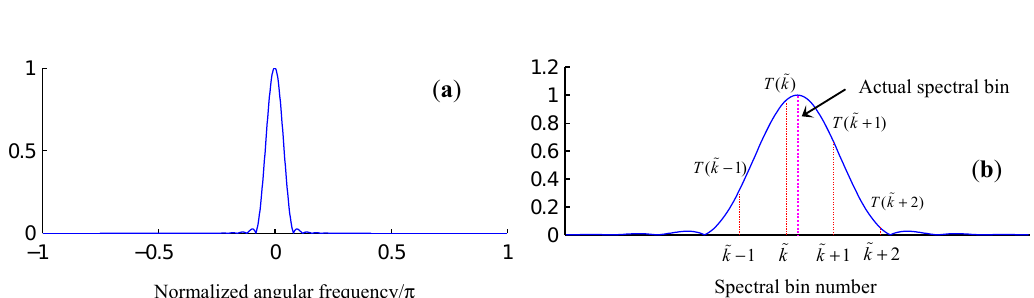
Figure 4. Hanning window-based spectrum correction: ( a ) the magnitude response; ( b ) the spectral bins within the main lobe.